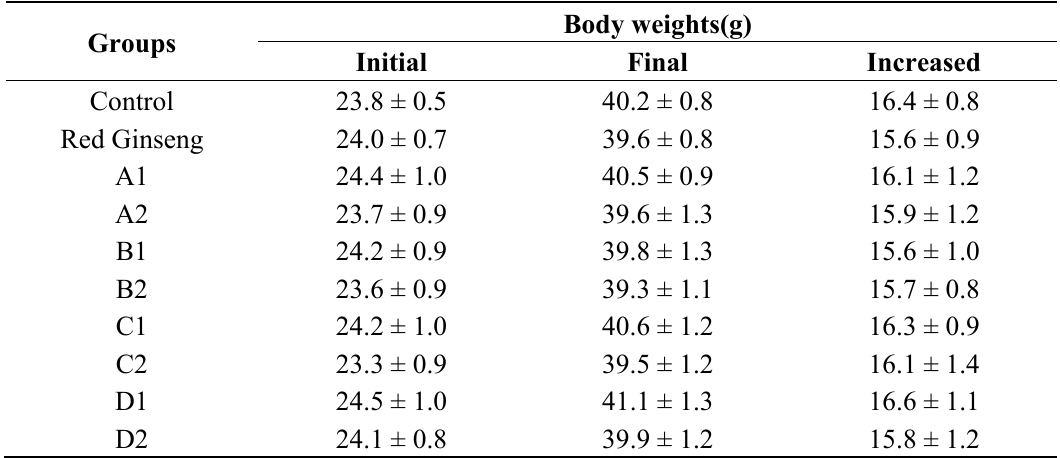
Table 1. The effects of the fractions of RPL and red ginseng on mice body